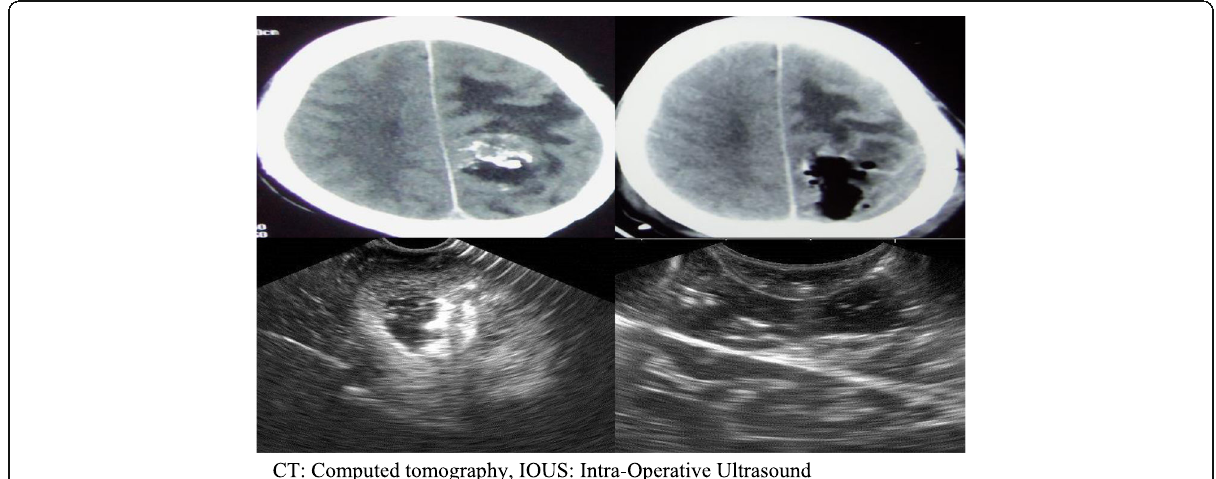
Fig. 4 Gross total resection of calcified astrocytoma grade 2; preoperative and postoperative CT with contrast and IOUS